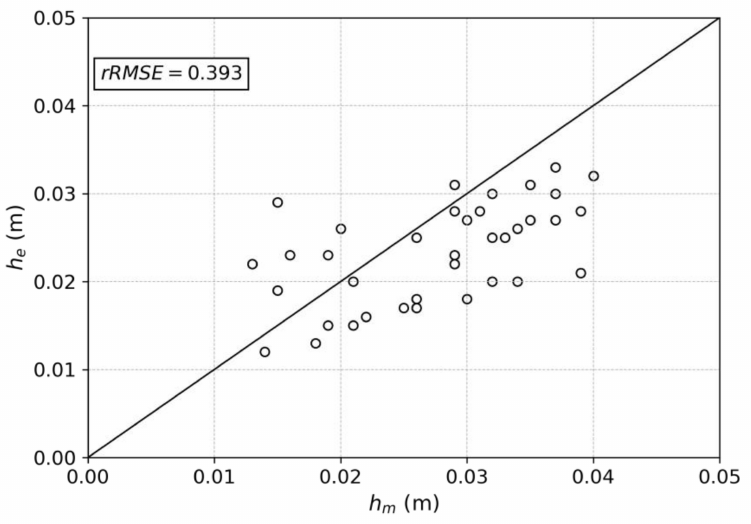
Figure 12. Comparison between the measured and estimated